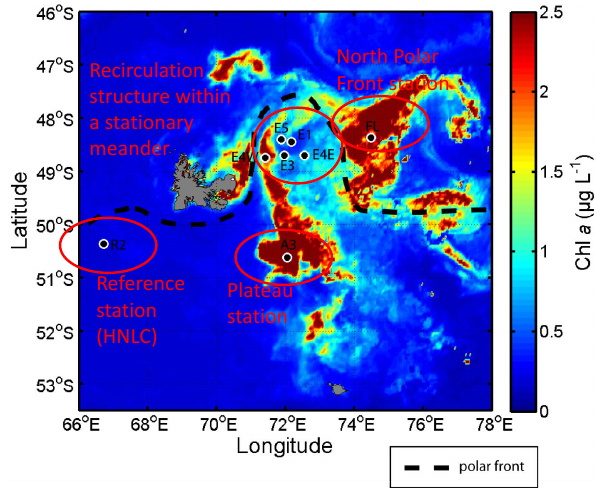
Figure 1. SeaWiFS surface chlorophyll on 11 November 2011, ap- proximately half way through the KEOPS2 sampling program. Ker- guelen and Heard Island are visible in grey. Stations that were sam- pled for suspended particles are indicated with black circles. Dis- tinct regimes of interest for the KEOPS2 program are indicated in